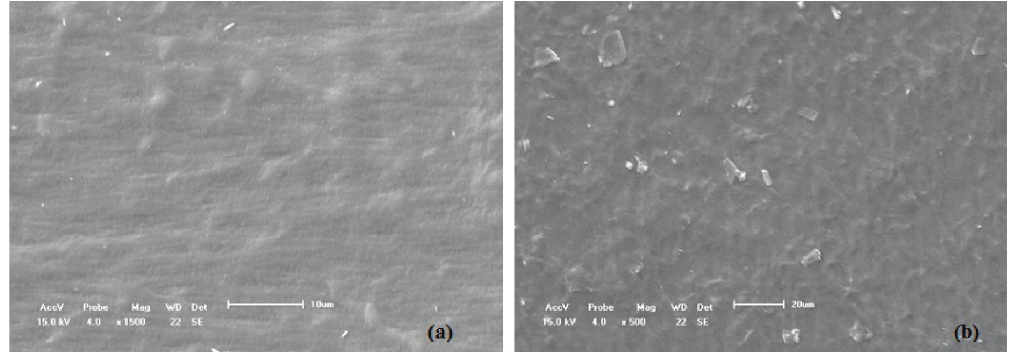
(b) samples not submitted to simulated soil – control samples. OX